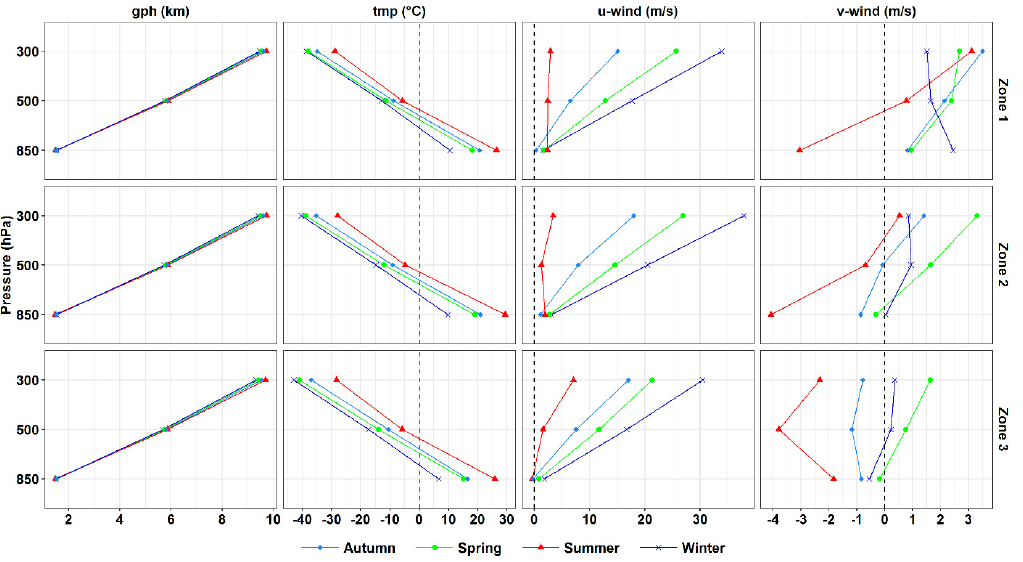
Figure 6. Seasonal mean vertical profiles of gph, tmp, and horizontal wind averaged over soundings. Reanalysis data did not perform equally at the seasonal level. All reanalyses underestimated gph over the entire region, except for ERA-5 during spring at the upper levels, as shown in Figure 7a. During winter, the mean biases of gph ranged from − 9 (850 hPa) to − 24 m (300 hPa) over zone one; MEERA had the smallest mean bias values at all the pressure levels ( − 9 to − 13 m), followed by ERA-I with roughly 2 m greater di ff erences at the upper levels. However, over zone one, ERA-I outperformed MEERA in representing the gph’s distribution of soundings, as displayed in Figure 7a. Over zones two and three, mean gph biases ranged from − 8 to − 18 m (zone two) and − 3 to − 20 m (zone three); ERA-I showed the minimum biases at most heights during winter. During spring, mean gph biases were mostly similar over each zone, − 8 to − 19 m (zone two), − 7 to − 18 m (zone three) and − 10 to − 21 m (zone one), excluding ERA-5 which showed large di ff erences from observations in most cases. During this season, most RDs displayed comparable gph biases at 850 hPa over each zone, and MEERA (ERA-I) showed smaller biases at upper levels over zones one and two (three). Nevertheless, ω r 2 values were lower in the lower troposphere (except over zone three) and higher at the upper